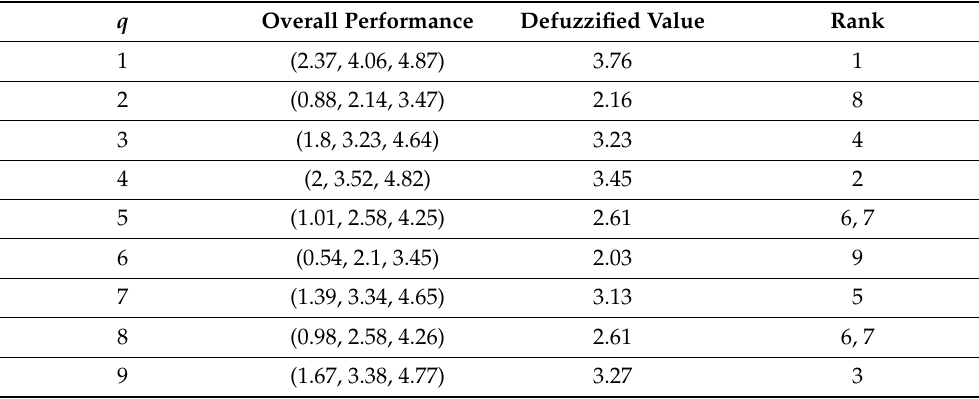
Table 10. Overall performances of smart technology applications evaluated using